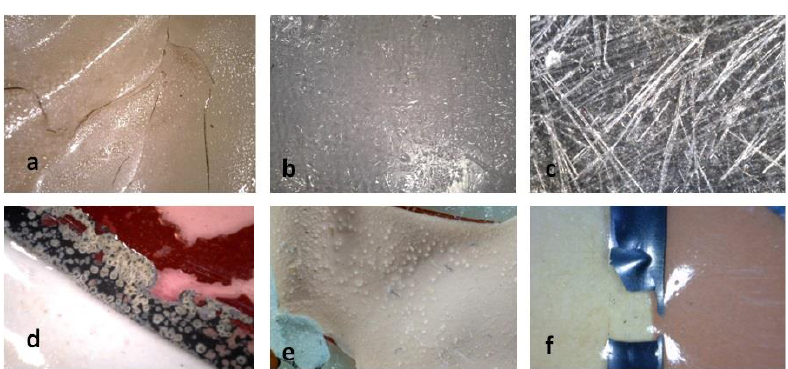
Figure 1. Visible light images of the analyzed Rodovetri: ( a ) La Rosa di Bagdad (1949), ( b ) Vegetallumina (1959), ( c ) Caio Gregorio (1960), ( d ) Brandy Gran Senior (1974), ( e , f ) Serie Stock (nd).